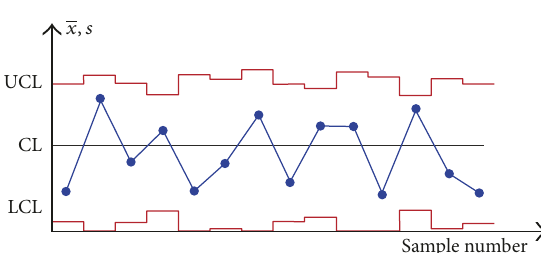
Figure 1: Typical 𝑥 chart and 𝑠 chart with variable sample